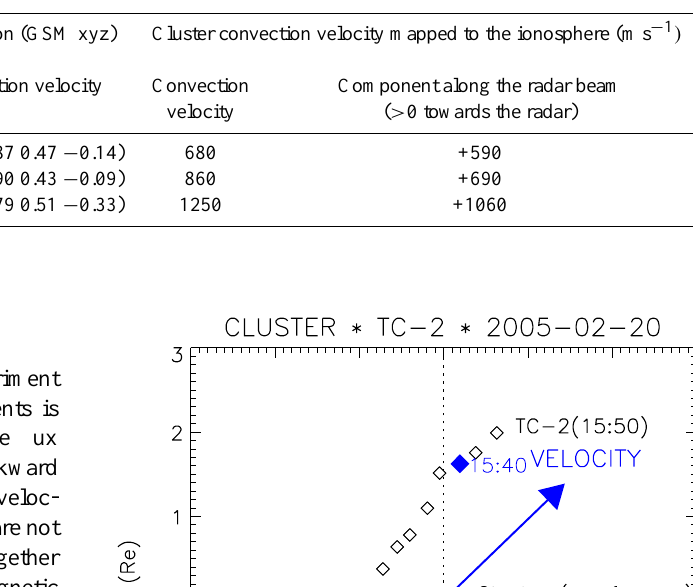
Table 1. Velocity of injections flux tubes and convection velocity at Cluster and mapped into the ionosphere along magnetic field lines and along the SuperDARN Stokkseyri radar beam with which Cluster is magnetically conjugated.